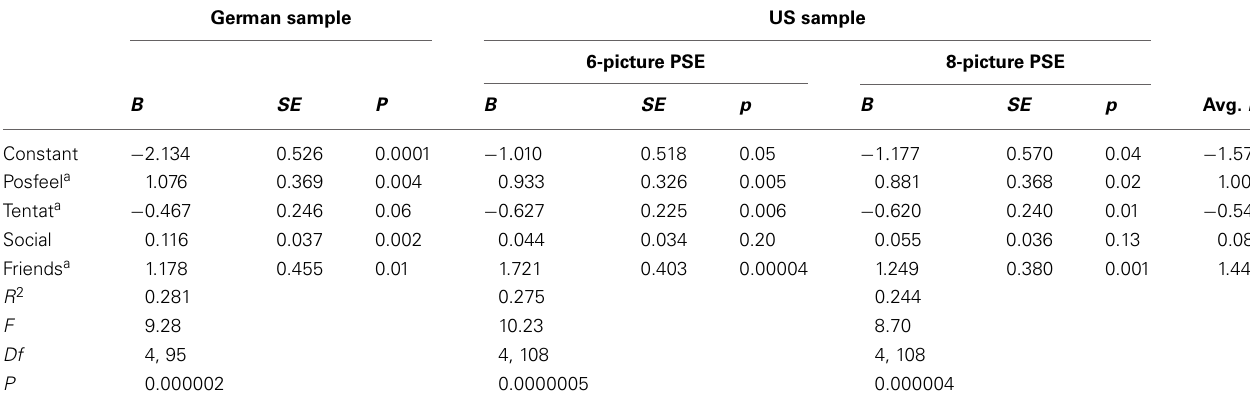
Table 5 | Simultaneous regression of n Affiliation scores (residualized for word count) on LIWC 2001 categories that are significant zero-order predictors in both samples and are non-redundant (Study